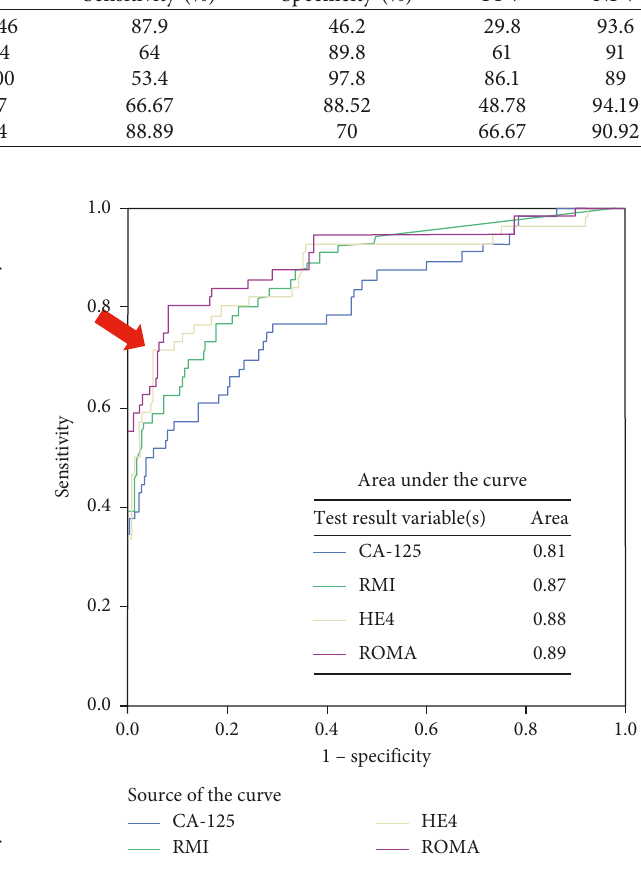
Table 2: Median, interquartile range, and range and diagnostic value of CA-125, RMI, HE4, and ROMA. Tools